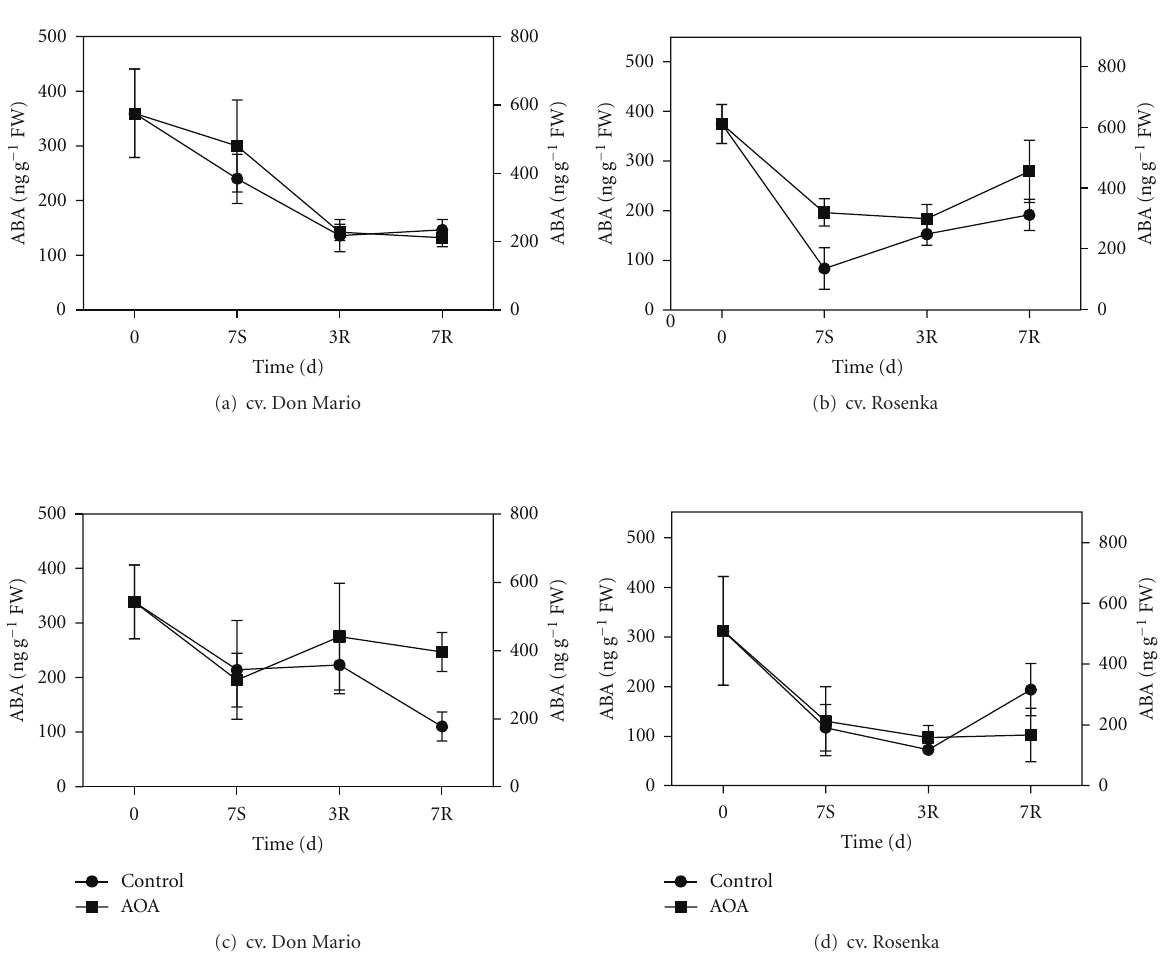
Figure 4: Endogenous ABA content from leaves of cv. Don Mario (a) and cv. Rosenka (b) and from flowers of cv. Don Mario (c) and cv. Rosenka (d) stored for 7 days (7S) at 14 ◦ C and transferred at 20 ◦ C for recovery evaluation (3R and 7R). Values are means with standard errors ( n = 10). Data were subjected to one-way ANOVA, and di ff erent letters, when present, mean that values are statistically di ff erent, P < 0 . 05.